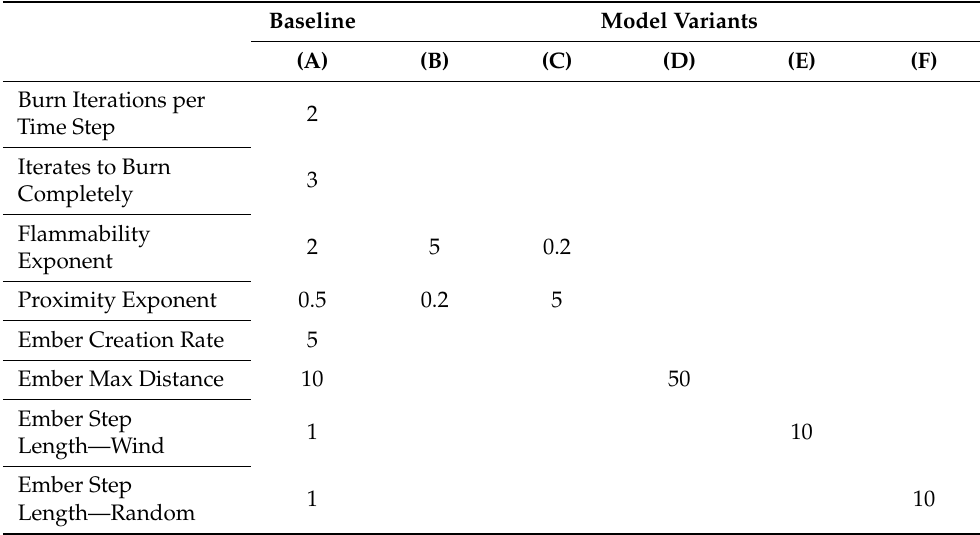
Table 3. Example 1 input parameters. Labels used to distinguish the six experiments are shown in parentheses. Experiments B–F were conducted using the baseline model (experiment A) parameters, except where